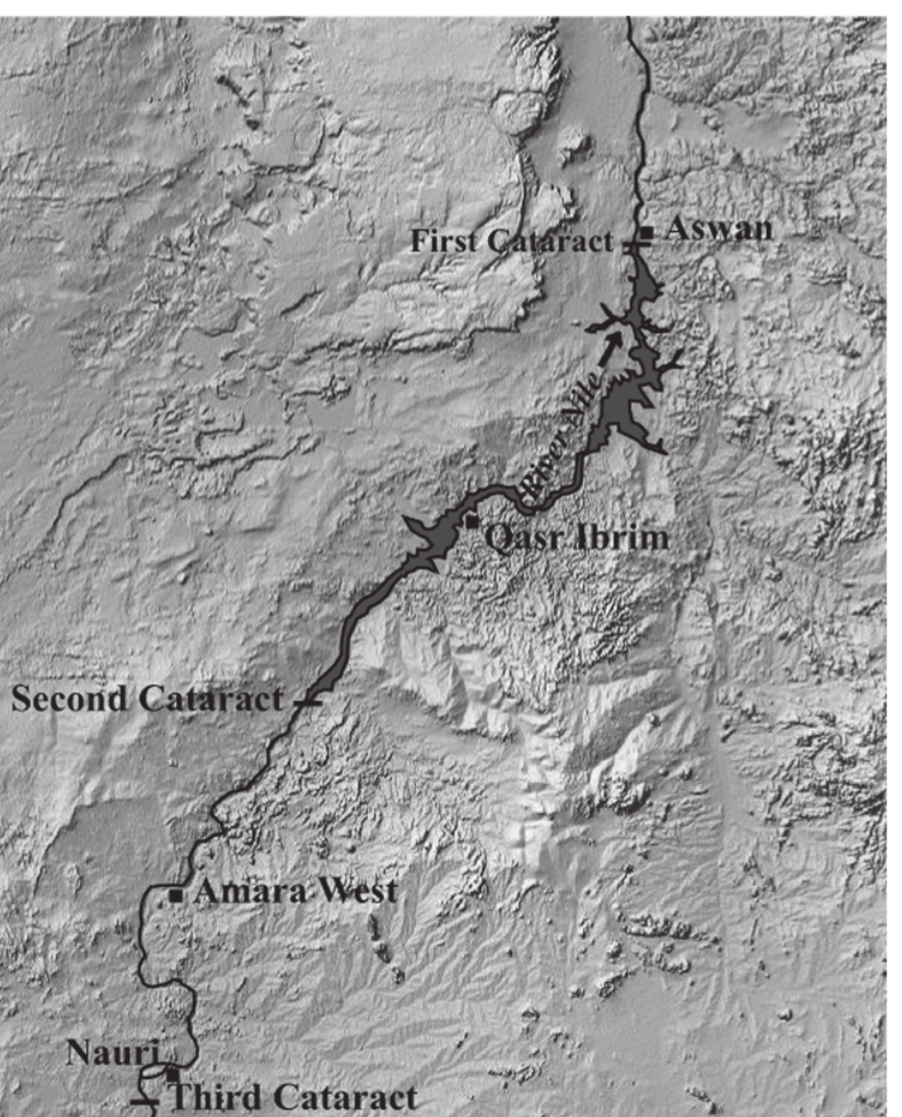
Figure 1. Map of Nubia. Locations of archaeological excavations at Tell el-Amarna, Qasr Ibrim, and Nauri and the cataracts along the River Nile are indicated.